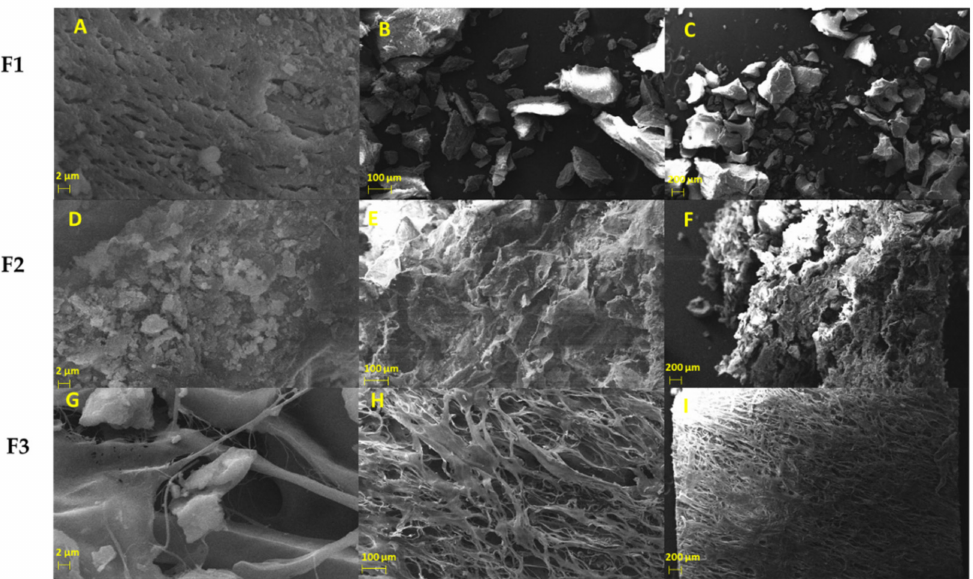
Figure 4. SEM analysis of F1 ( A – C ), F2 ( D – F ), and F3 ( G – I ). ( A , D , G ) at 5000 × . ( B , E , H ) at 100 × . ( C , F , I ) at 50 × . F1: InterOss. F2: InterOss Collagen. F3: InterCollagen Guide.